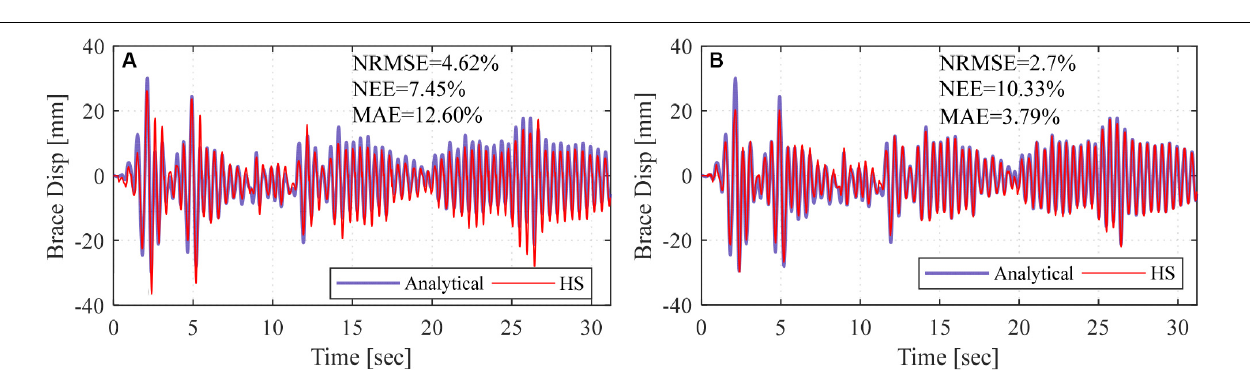
FIGURE 14 | Brace response from pure analysis and offline RTHS tests with deep LSTM network model located at local PC and trained using (A) 15 and (B) 20 lookbacks.